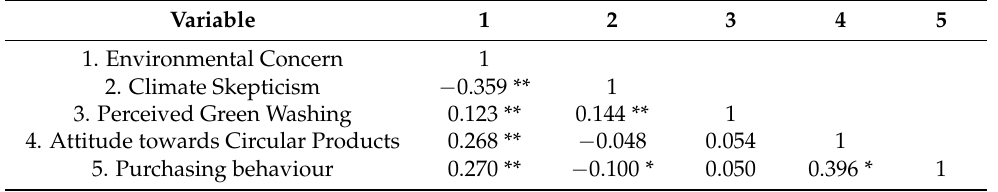
Table 4. Pearson correlations for all of the study variables.